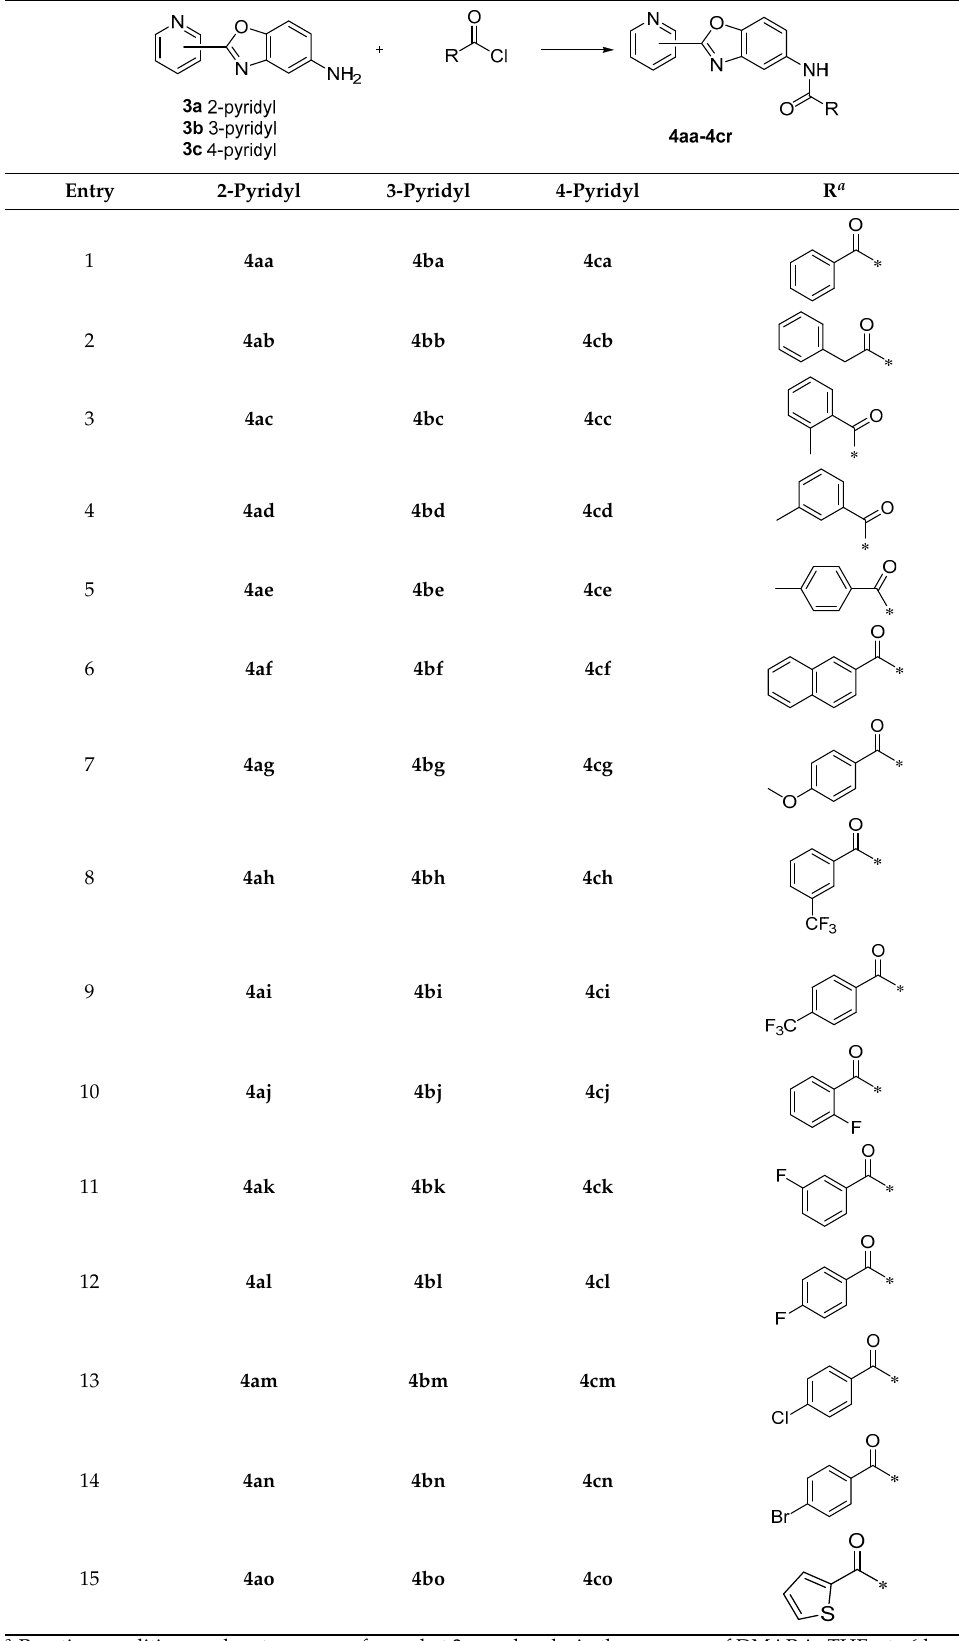
Figure 3. X-ray crystallographic structures of 4ac and 4bc . Table 1. The syntheses of amide derivatives of benzoxazoles a .